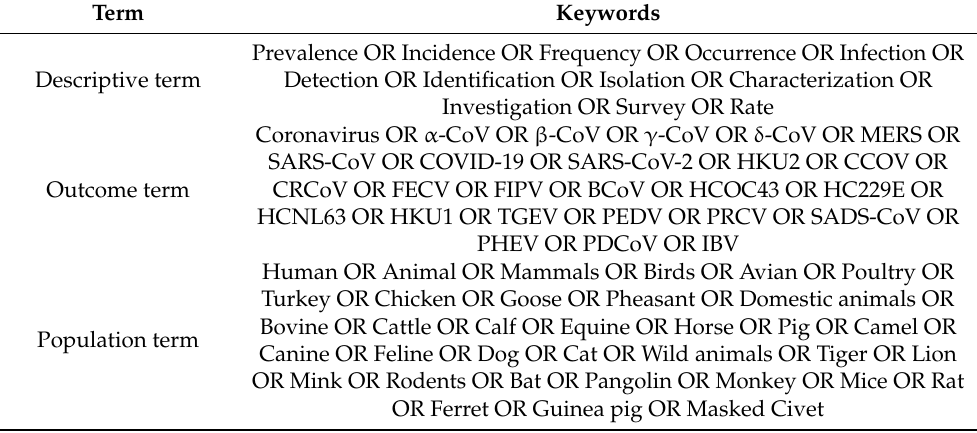
Table 1. Keywords for searching published literature in different databases.